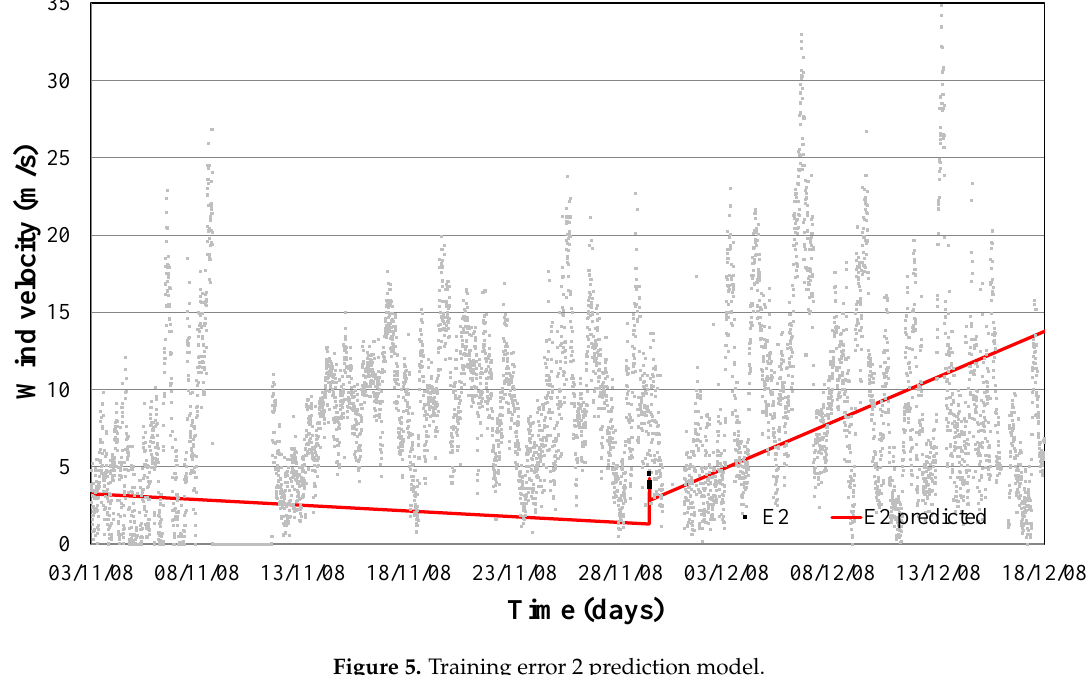
Figure 5. Training error 2 prediction model. Sensors 2021 , 21 , x FOR PEER REVIEW